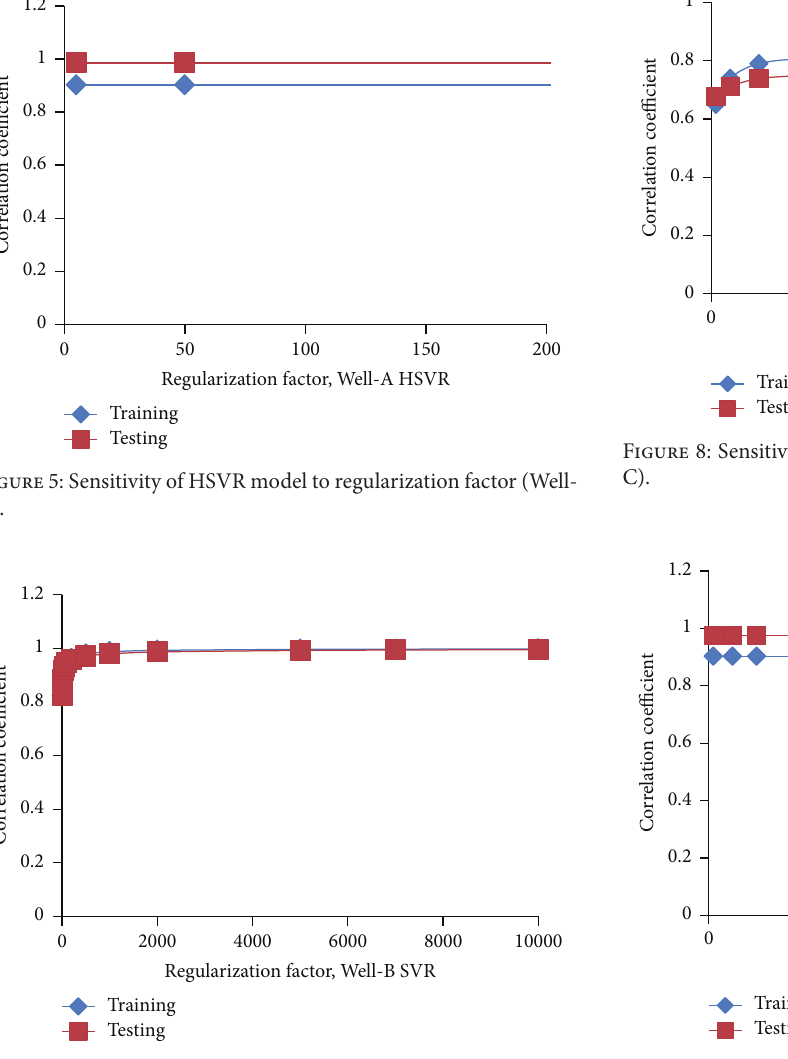
Figure 9: Sensitivity of HSVR model to regularization factor